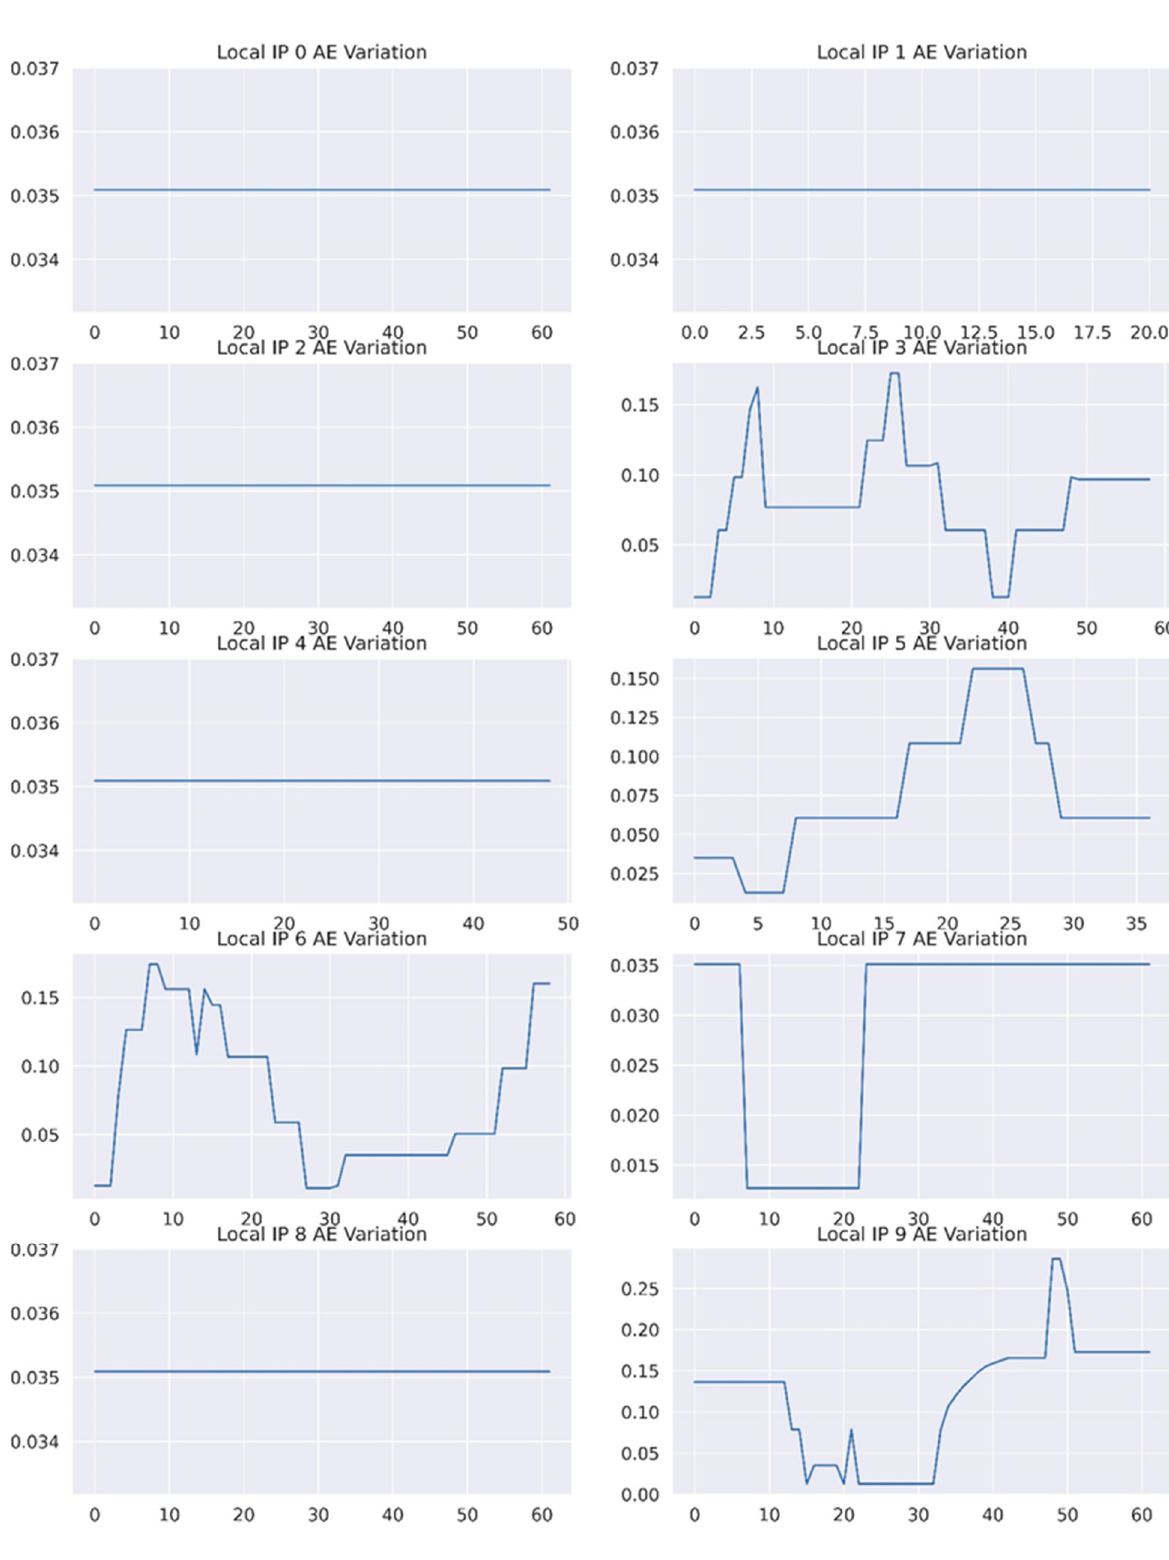
Figure 6. AE values for all IP addresses during the observation period .